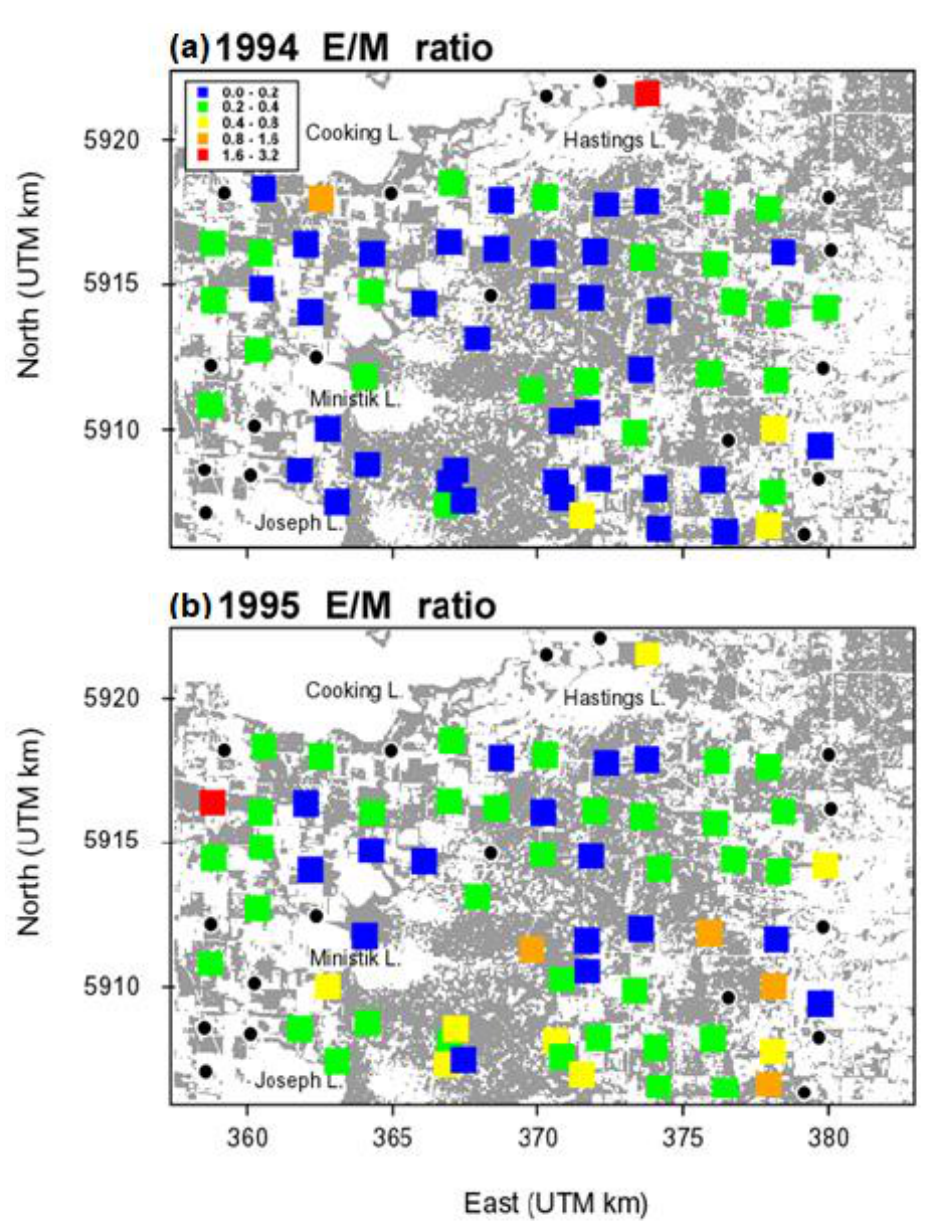
Figure 4. The spatial pattern of forest tent caterpillar E/M ratio across the 20 km × 15 km Cooking Lake study area, in ( a ) 1994 and ( b ) 1995. Grey shading indicates forest cover, primarily trembling aspen. Black circles are population plots for which the egg density or moth density was missing.